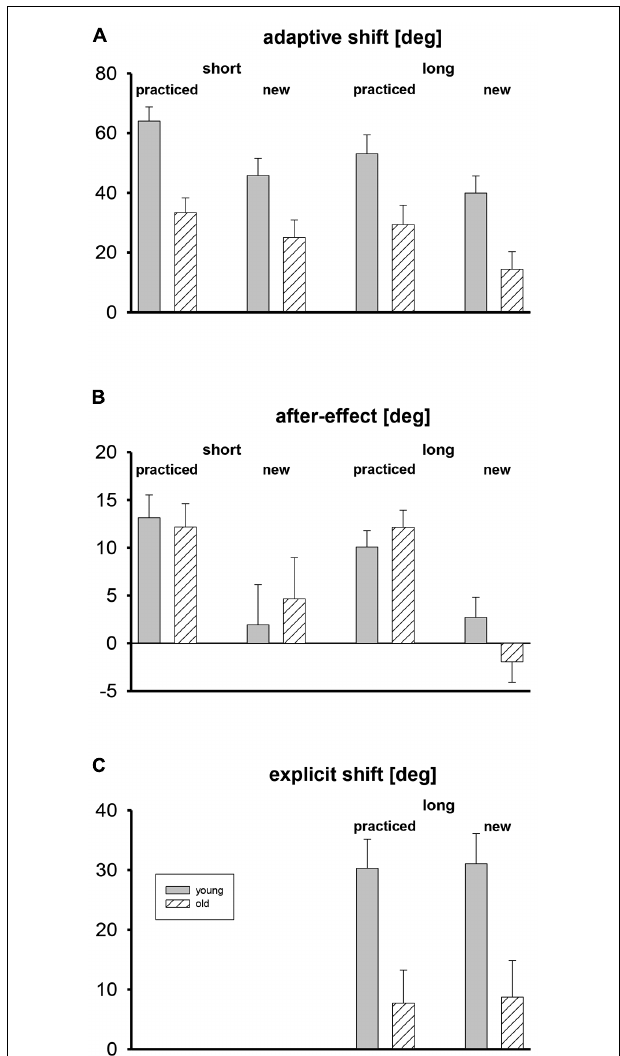
FIGURE 2 | Mean adaptive shifts (A), after-effects (B), and explicit shifts (C) in deg, shown separately for short and long target amplitudes, practiced and new target directions, and both age groups. Error bars mark standard errors of the means.